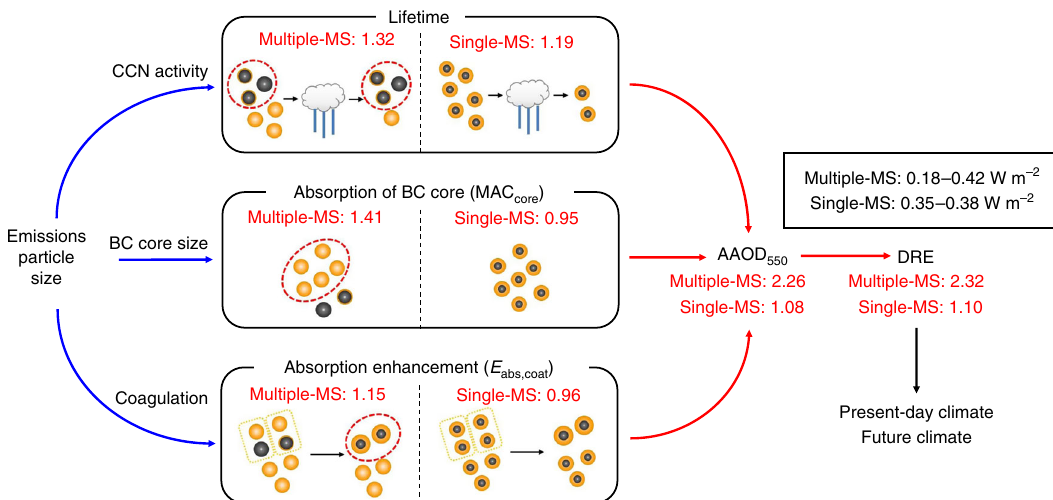
Fig. 4 Causes of high sensitivity of black carbon direct radiative effect by resolving mixing state. The fl owchart shows why the Multiple-mixing-state representation results in high sensitivity of black carbon (BC) direct radiative effect (DRE) due to emission size distributions. Blue and red arrows show negative and positive responses, respectively, in the Multiple-mixing-state representation. Speci fi cally, decreasing particle sizes at emission (e.g., Small- size simulation) increases BC lifetime, BC core absorption, and absorption enhancement, and these enhancements increase absorption aerosol optical depth at 550 nm (AAOD 550 ) and DRE of BC in the Multiple-mixing-state representation. The values shown by red are the ratios between the Small-size and Large-size simulations. The representation of particles in red circles is especially important for accurate calculations of the lifetime (pure BC and thinly- coated BC particles), BC core absorption (BC-free particles), and absorption enhancement (thickly-coated BC particles) effects, which are the causes of different BC DRE sensitivity between the Multiple-mixing-state and Single-mixing-state representations